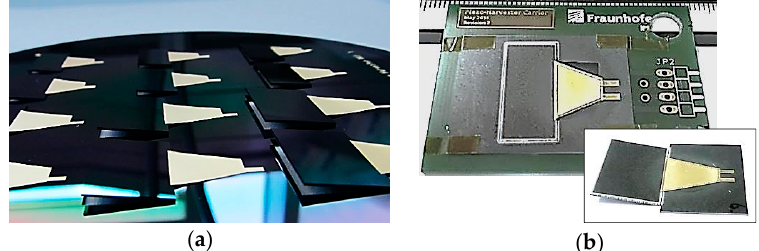
Figure 2. Fabricated harvester cantilever: ( a ) Cantilever structures on a silicon wafer; ( b ) Examples of a cantilever of 25 × 20 mm 2 footprint and a cantilever chip of 18 × 20 mm 2 footprint on a PCB.